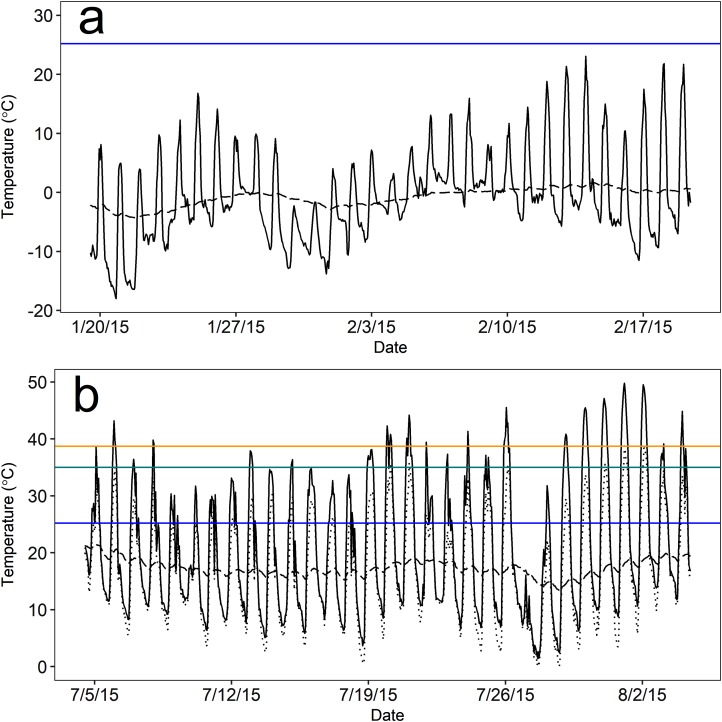
Mean operative temperature (Te) at above-ground microsites (solid black line) and temperatures within pygmy rabbit (Brachylagus idahoensis) burrows (dashed black line).Temperature was measured during the (A) winter (20 January–19 February, 2015) and (B) summer (5 July–4 August, 2015) in east-central Idaho, USA. Mean temperatures above and below ground remained below the lower critical temperature (blue line) for the duration of winter monitoring. Mean above-ground Te often exceeded the estimated upper critical temperature (green line) and body temperature (orange line) of pygmy rabbits during summer, but there were typically above-ground rest sites available that were cooler than the mean (lowest hourly Te measured by a single operative temperature model; dotted black line).